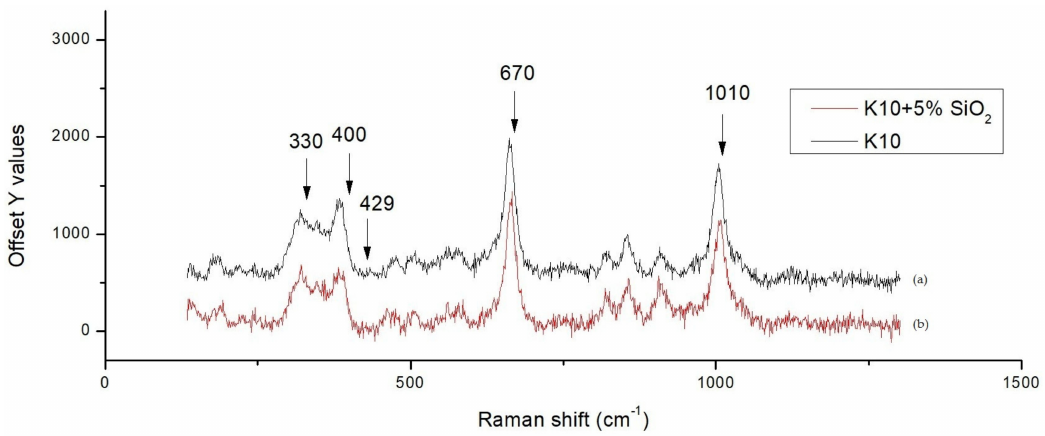
Figure 6. Raman spectra for ( a ) without SiO 2 added diopside glass-ceramic; and ( b ) with SiO 2 added diopside glass-ceramic.